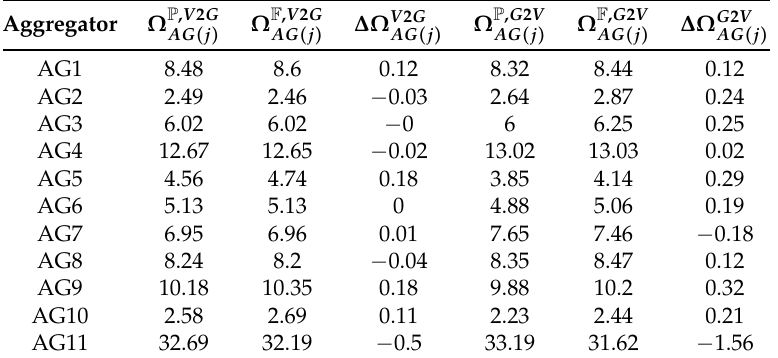
Table 5. Aggregator coordination factor data for 10% EV penetration level with 3 kW charger rating.